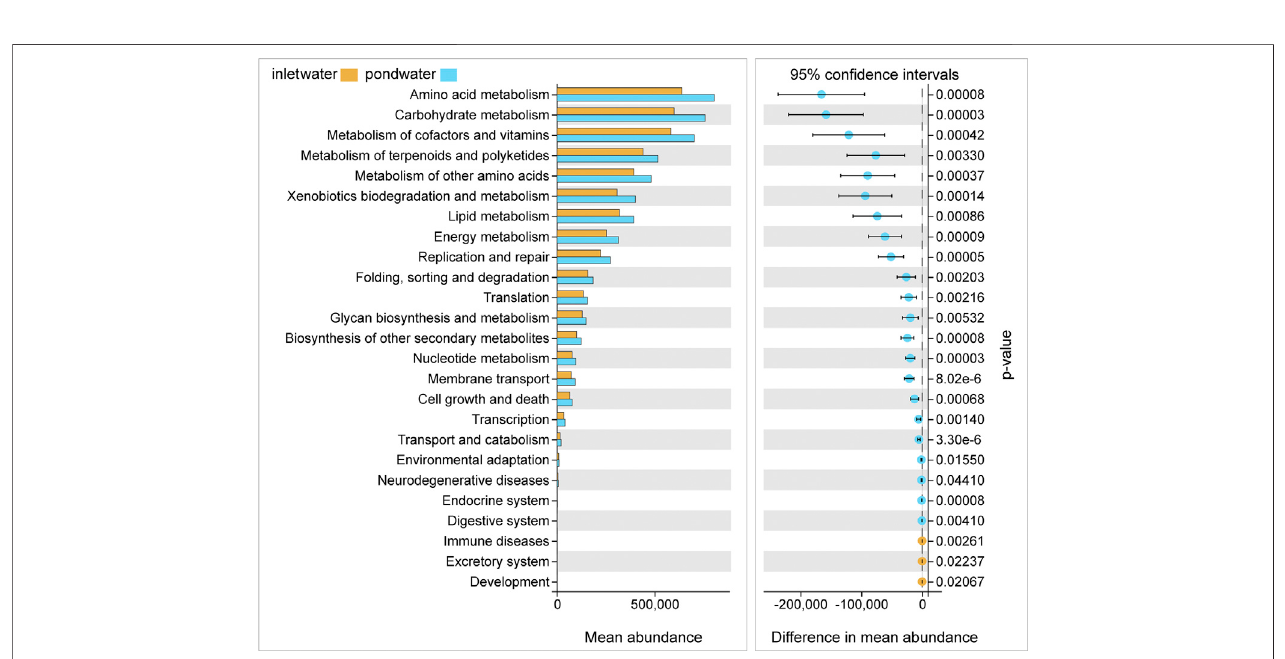
FIGURE 3 | Analysis of bacterial communities in inlet water and pond water; dominant bacterial taxa in the samples at the class (A) and genus (C) levels; statistical analysis of signi fi cant differences in bacterial class (B) and genera (D) (Wilcoxon rank sum test, p < 0.05).